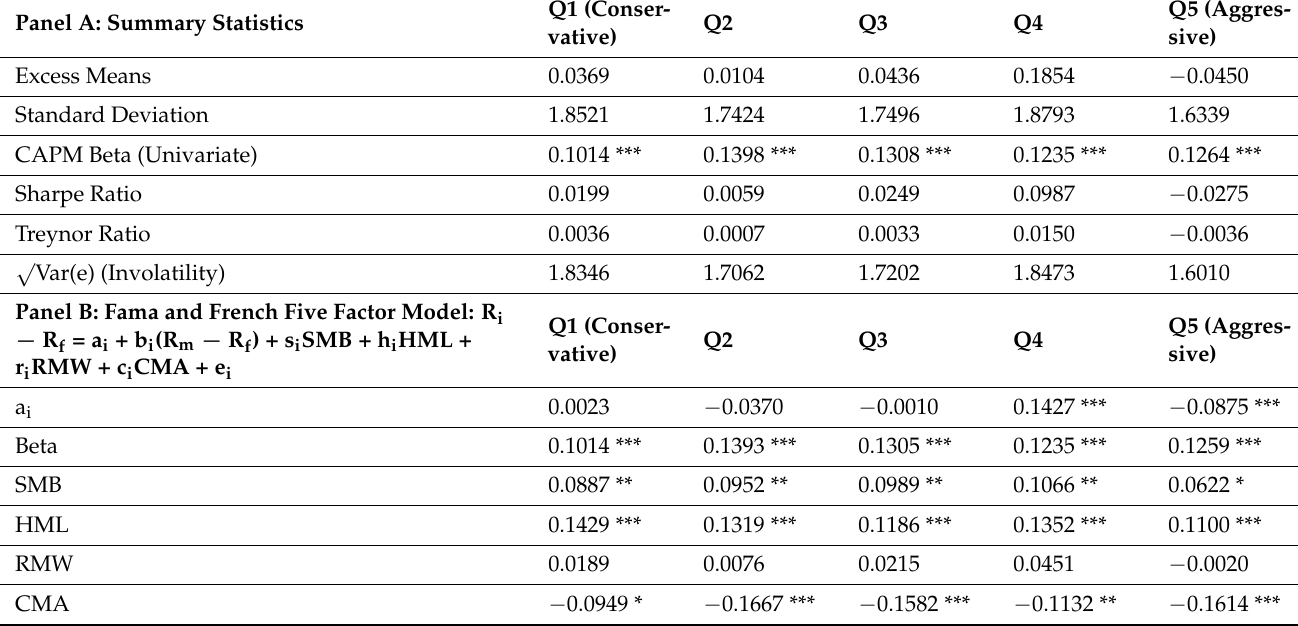
Table 5. Risk measures for Conservative and Aggressive Investment REIT portfolios